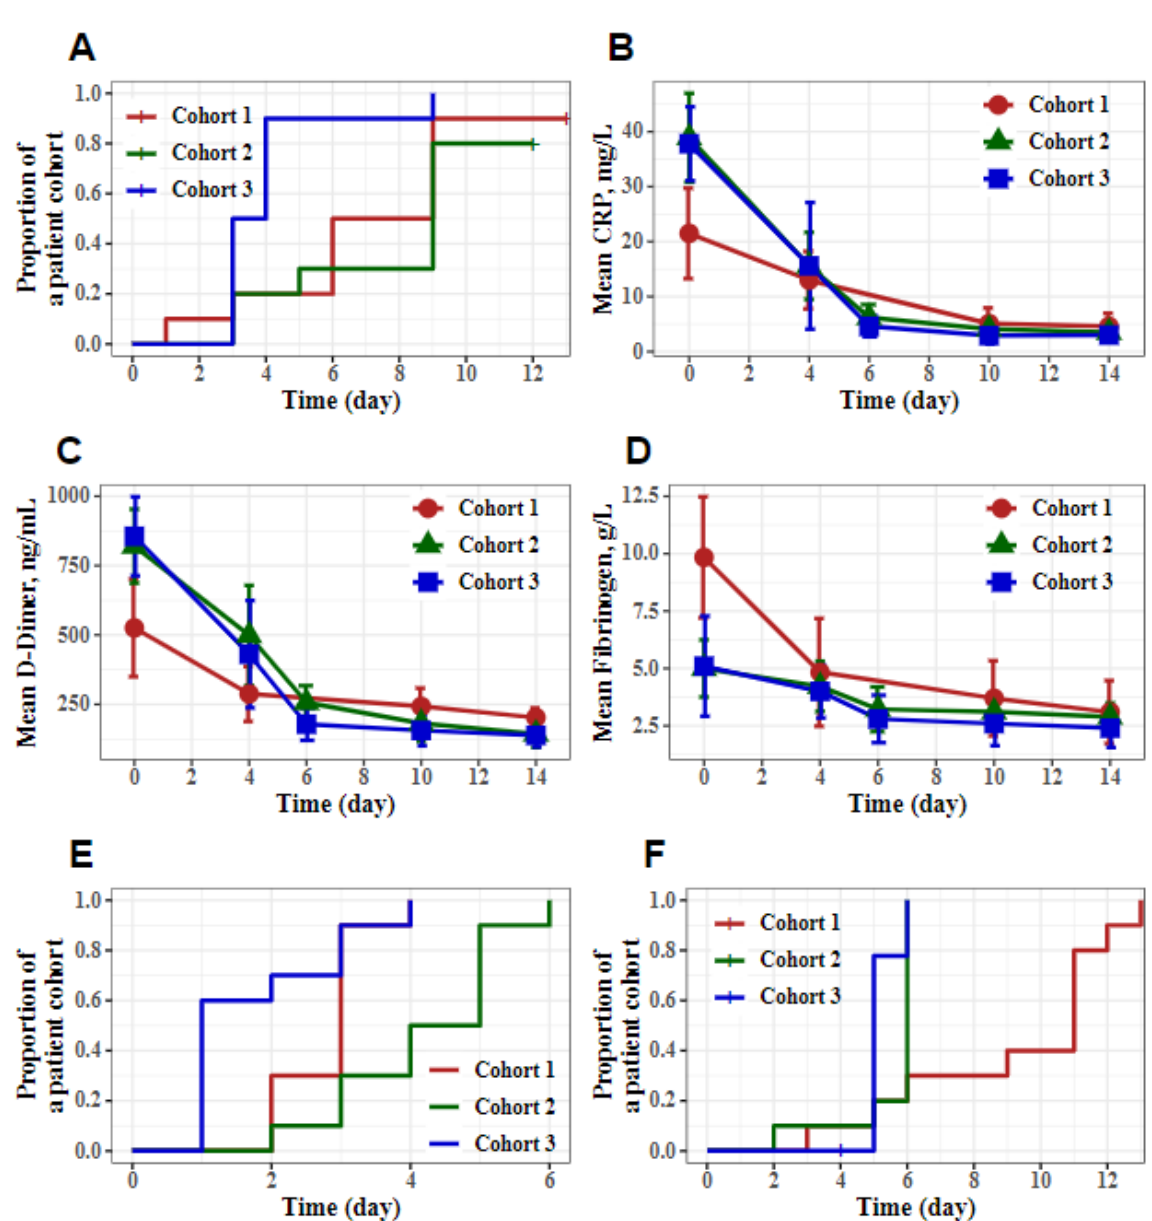
Figure 1. Effect of aprotinin and HCQ or Avifavir ® (cohorts 1–3) combination therapy on the primary and secondary efficacy endpoints in COVID-19 patients. The panels show ( A ) the elimination of SARS-CoV-2 (days) and ( B ) CRP concentration (mg/L). Normal concentration of CRP is ≤ 10 mg/L. ( C ) D-dimer concentration (ng/mL). Normal concentration of D-dimer is ≤ 253 ng/mL. ( D ) Fibrinogen concentration (g/L). Normal range of fibrinogen is 2–4 g/L. ( E ) Normalization of the body temperatures (<37 °C) time since the initiation of treatment (days). ( F ) Improvement of the clinical state by 2 points (according to the WHO-OSCI) in the time since the initiation of treatment (days). (A,E,F) Show the time since the initiation of treatment (days). (B,C,D) Show the time from inclusion (days).